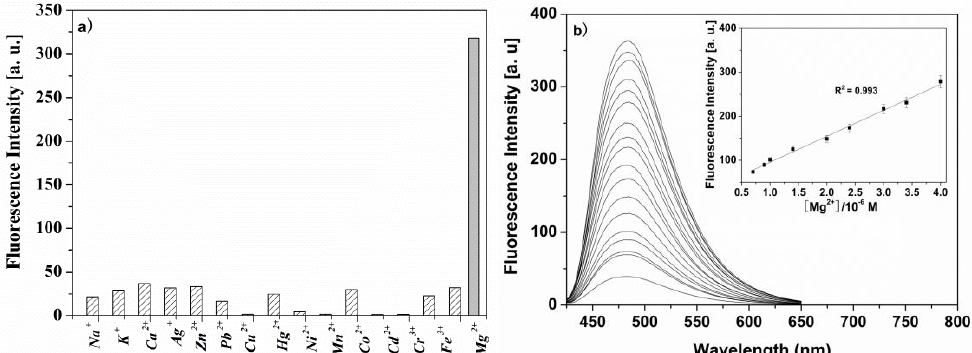
Figure 2. ( a ) Fluorescence spectra of P (10 μ M) with the tested cations (10 µM) in water – ethanol solution (1:9, v : v , pH 10.0, 20 mM HEPES). ( b ) Fluorescence titration experiment of P (10 μM) with different concentrations of Mg 2+ in water – ethanol solution (1:9, v : v , pH 10.0, 20 mM HEPES). Inset: the fluorescence of P (10 μM) as a function of various Mg 2+ concentrations (0.9 –4.0 μM).